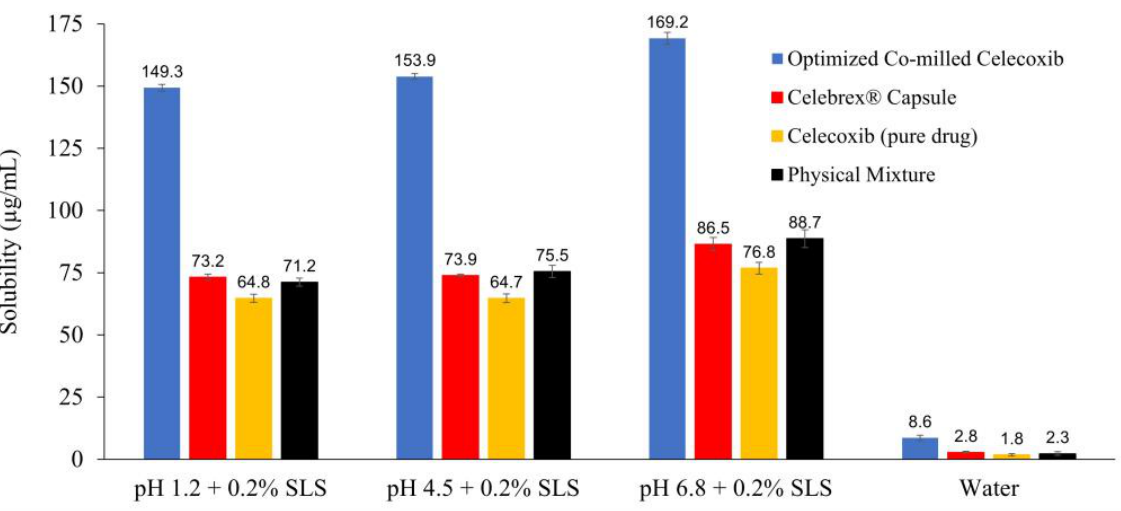
Figure 4. Apparent solubility of CXB pure powder, PM, Celebrex ® capsule, and optimized co-milled CXB in different media (n = 3, mean ± SD).